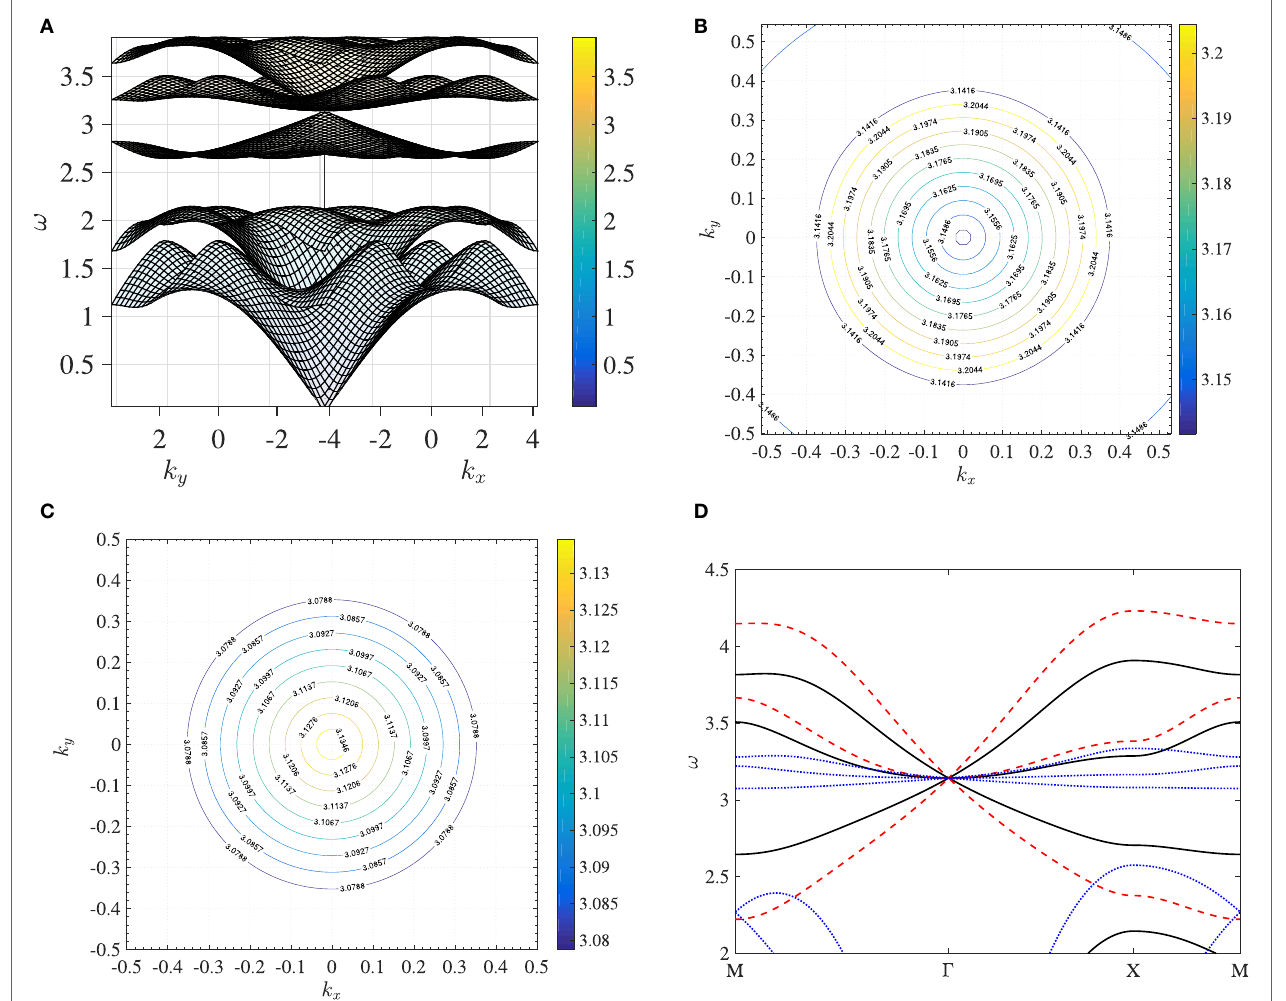
FIGURE 3 | In panel (A) , a side view of Figure 2 is provided. Panels (B,C) are slowness contours of panel (A) . The frequencies represented here lie just above panel (B) and just below panel (C) ω = π , corresponding to the Dirac-like point. The color scale represents Bloch-Floquet frequencies ω . Panel (D) shows the dispersion curves of the optical modes for three set of lattice parameters. The solid black lines correspond to the lattice parameters used in panel (A) ; red dashed lines and blue dotted lines correspond to “set 2” and “set 3” in Table 1 , respectively.